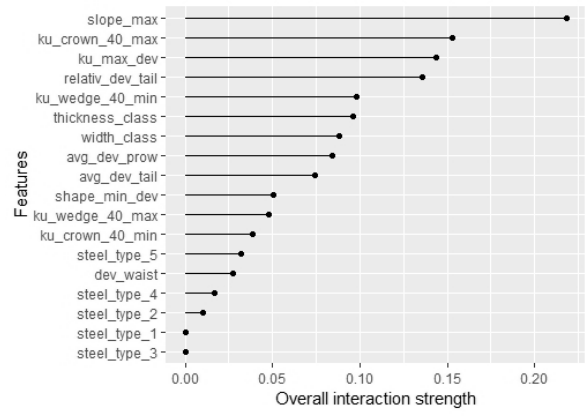
Figure 9: The 2-way interaction strengths (H-statistic) between the most important feature slope_max and the other features.